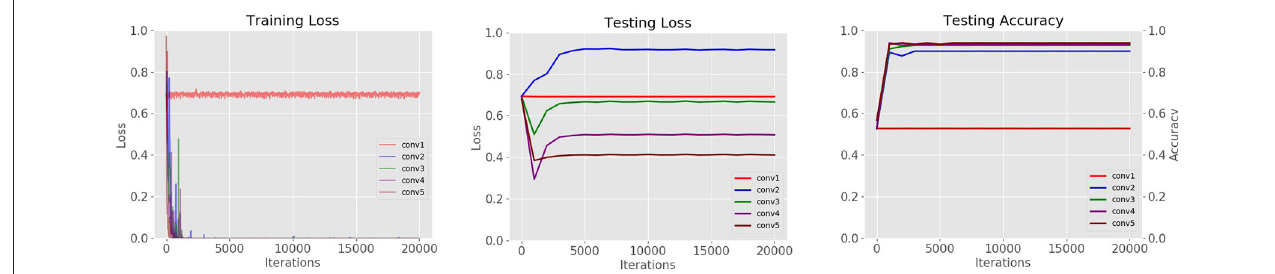
FIGURE 13 | Loss curves of CNN architectures with different layers studied in the refinement filter bank of our proposed approach.